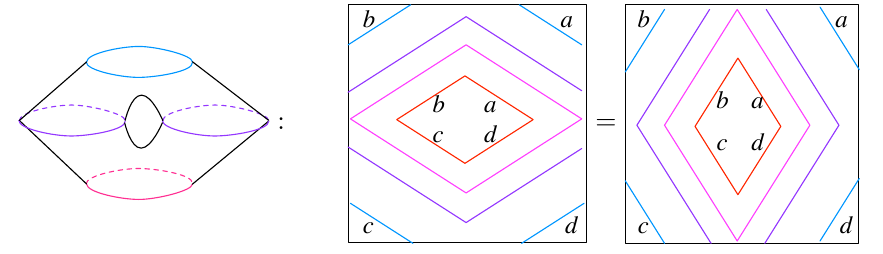
Figure 32 . Another possible topology change concerns a torus with two holes. On the two (cid:12)gures on the right, the time (cid:13)ows from inside to the outside, and the parallel edges of the boundary need to be identi(cid:12)ed to form a torus. On one side, the intermediate two circles are along the A-cycle, and on the other side, they are along the